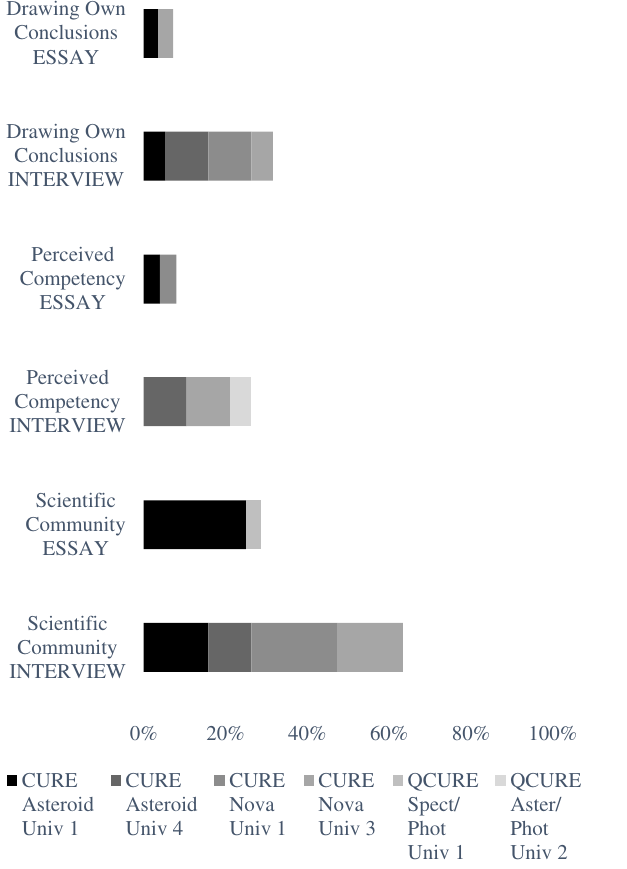
FIG. 4. Percentage of responses represented within each theme regarding the category of motivation, shaded by course type, project, and institution. Each theme is related to a motivational construct of SDT: autonomy, competency, and relatedness. Themes were generated from qualitative analyses of students ’ postinstruction essay ( n ¼ 28 ) and interview responses ( n ¼ 19 ) characterizing RBSEU instruction.